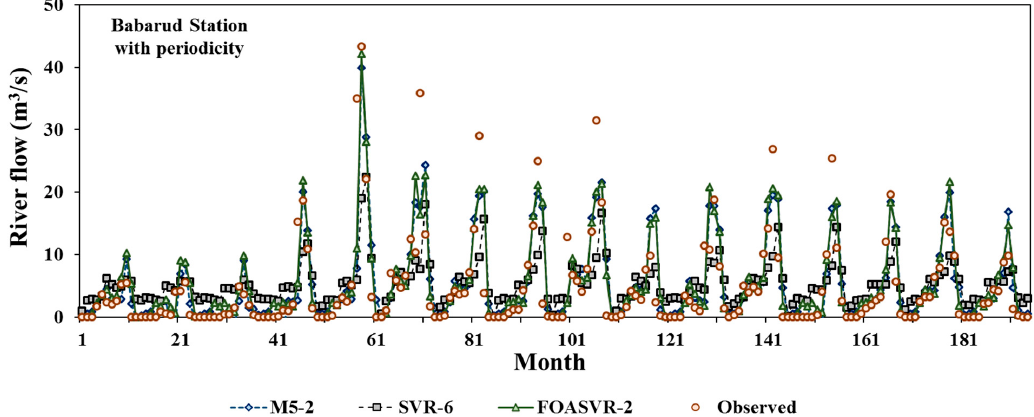
Figure 6. The observed and forecasted monthly river flows for Babarud station with periodicity.